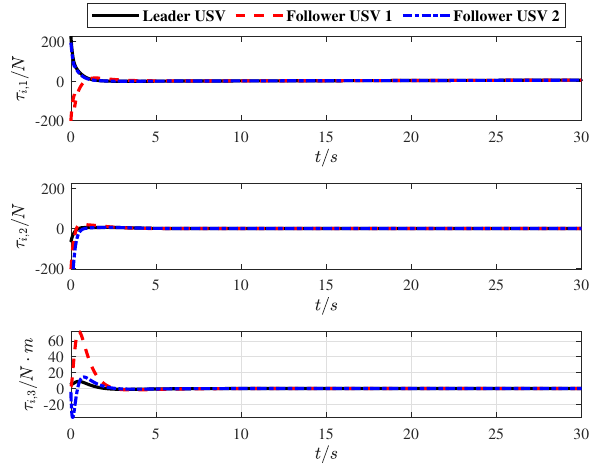
Figure 10. Input tracking.